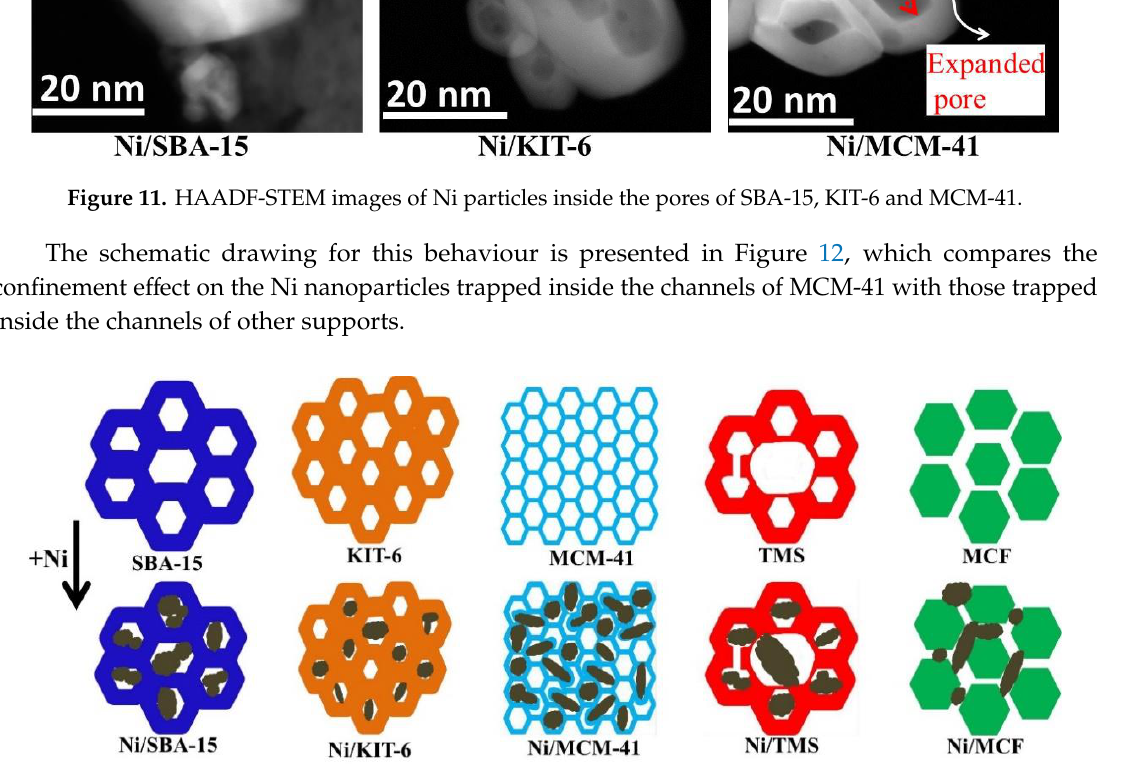
Figure 12. Suggested schematic of the confinement effect on the Ni nanoparticles trapped inside the channels of supports.